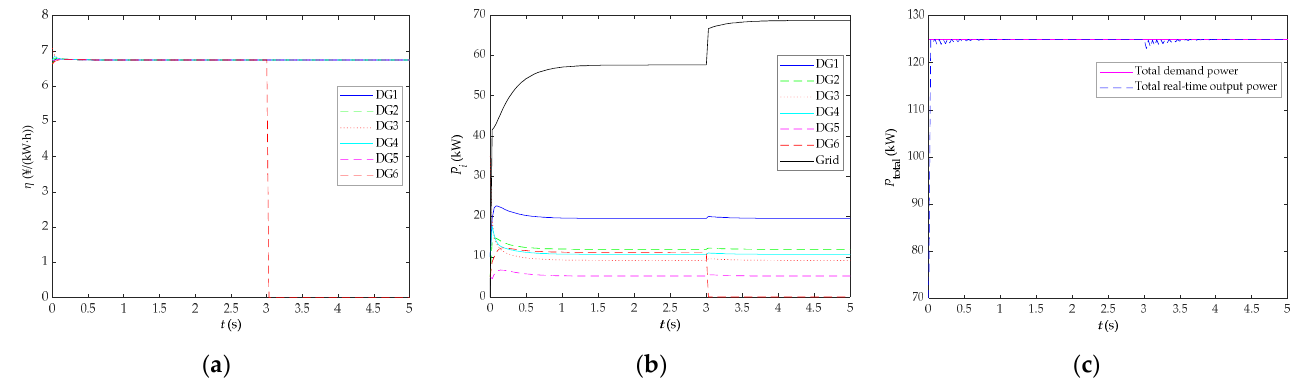
Figure 24. Change curves of variables of the system when the DG exits: ( a ) change curves of each DG’s ICR; ( b ) change curves of each DG’s active output and grid output power; ( c ) change curves of the cumulative sum of each DG’s active output and grid output power as well as total demand power.